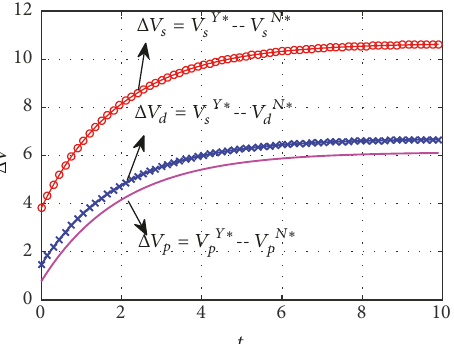
Figure7:Profitcomparisonforsupplychainpartiesbeforeandafter